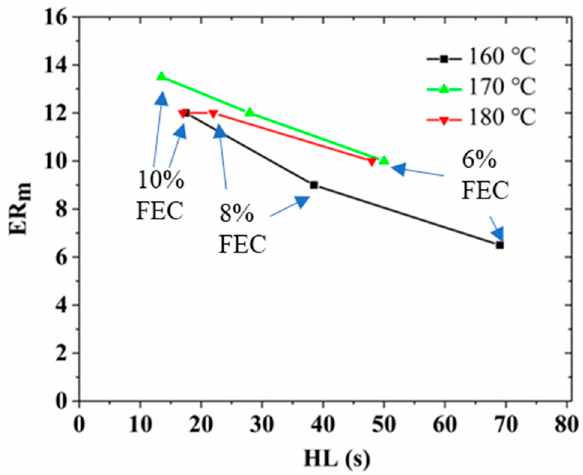
Figure 2. Relationship between ERm and HL of SFB at 160 °C, 170 °C and 180 °C.